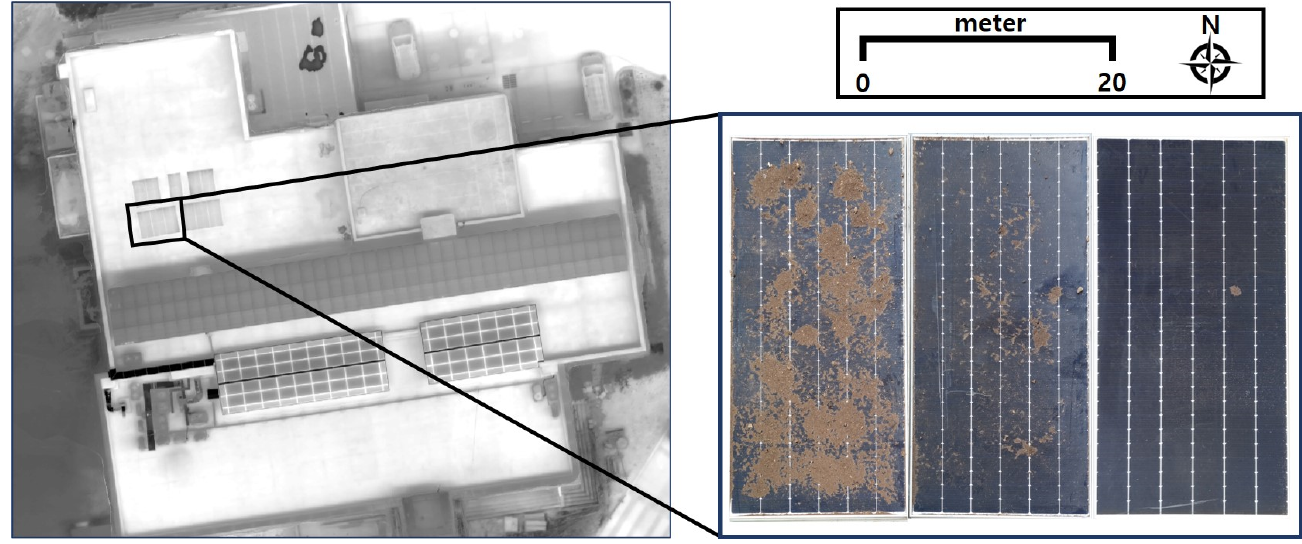
Figure 1. Mosaic of thermal imageries and an in situ photo of the study site. Black box is the location of experimental targets. The magnified picture (left side) is the in-situ photo of experimental targets.